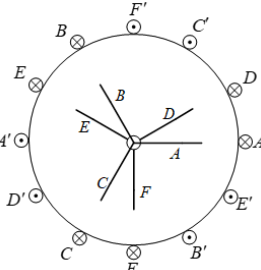
Figure 3. Spatial distribution of two sets of windings of dual three-phase motor. The spatial distribution of the 5th harmonic magnetomotive force in the motor differs by 150 ◦ electrical angle, as shown in Figure 4. Because the phase difference between the two sets of winding currents of the double three–phase motor is 30 ◦ , the space–time distribution of the 5th harmonic magnetomotive forces is 180 ◦ and offsets each other. Similarly, the phase difference in the spatial distribution of the 7th harmonic magnetomotive force, which is opposite to the rotation direction of the 5th harmonic magnetomotive force, is also a 150 ◦ electrical angle. The phase difference of the two sets of winding currents of the double three–phase motor is 30 ◦ , and the electrical angle also causes the space–time distribution difference of the 7th harmonic magnetomotive forces to be 180 ◦ and offset each other. In the DTP–SynRM, there will be no 5th and 7th harmonic rotating magnetic field, corresponding to the x – y subspace; the 5th and 7th harmonic impedance is very small. However, there are the 5th and 7th harmonics in the phase voltage of the winding, which will make the stator current of the motor contain a large number of 5th and 7th harmonics. These harmonic currents will cause additional losses to reduce the overall operating efficiency of the flywheel battery.